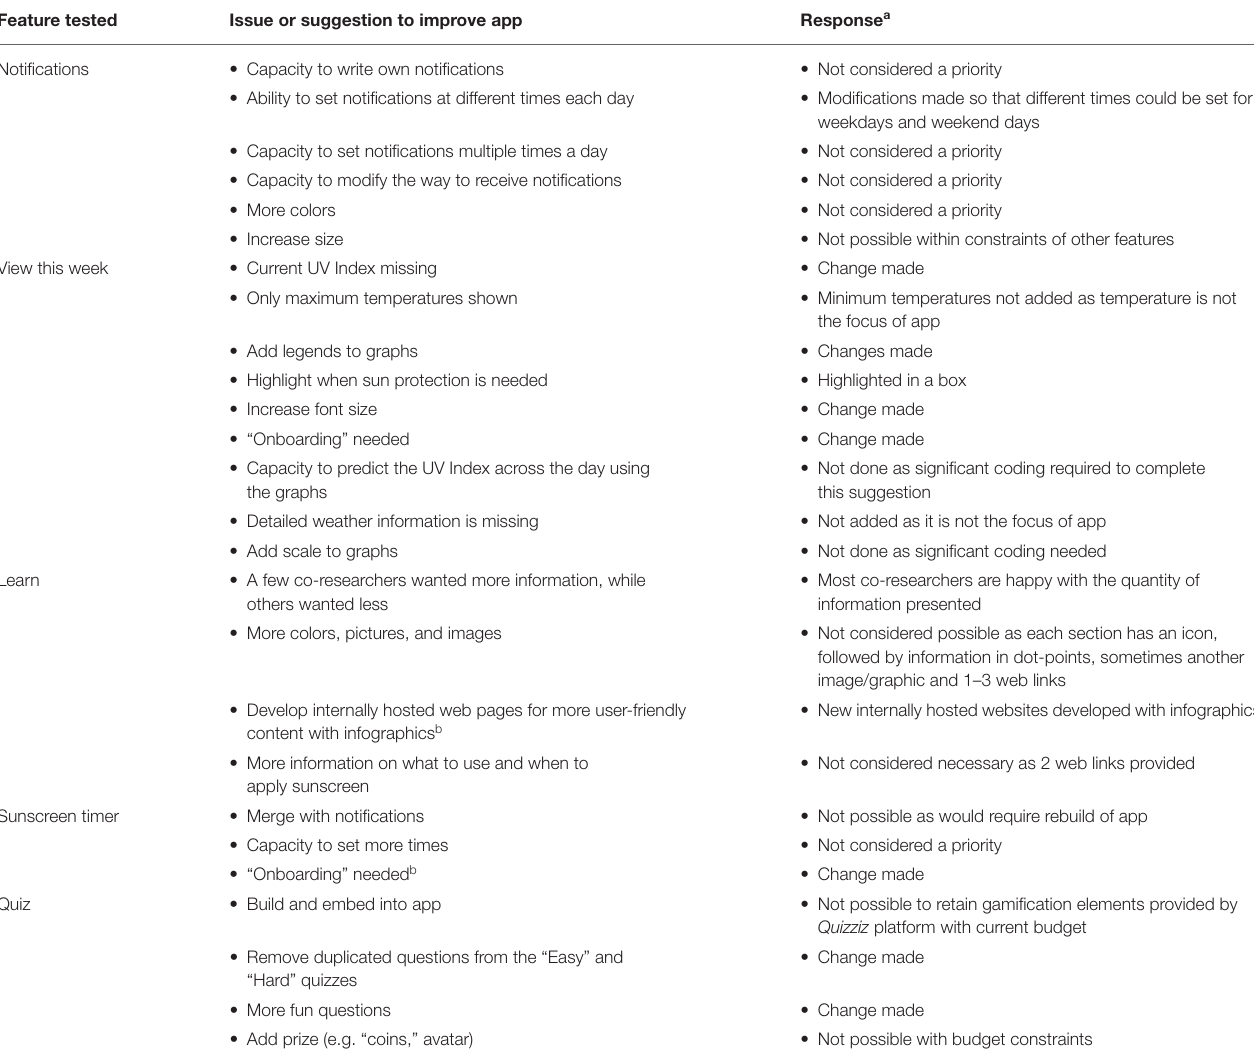
TABLE 6 | Issues arising with Sun Safe app by co-researchers at Workshop